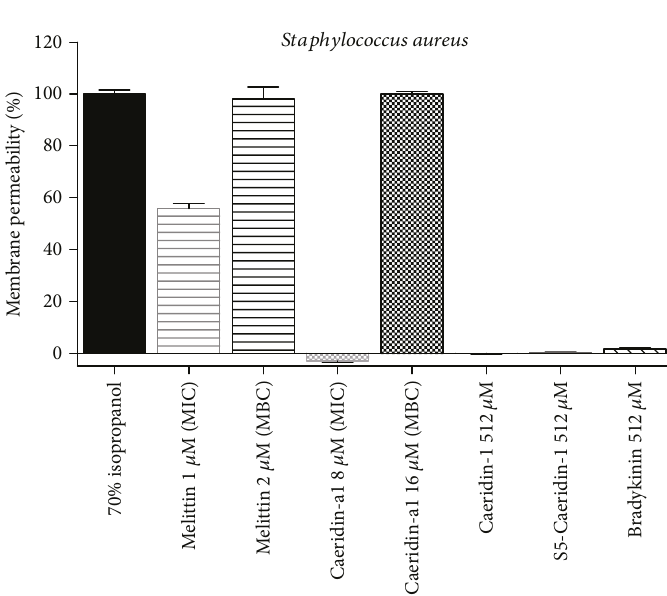
Figure 8: Membrane permeabilisation of S. aureus treated with melittin ( MIC = 1 μ M and MBC = 2 μ M ), Caeridin-a1 ( MIC = 8 μ M and MBC = 16 μ M ), Caeridin-1 (512 μ M), S5-Caeridin-1 (512 μ M), bradykinin (512 μ M), and 70% isopropanol for 2 h. The degree of membrane permeability was calculated in comparison with the maximum membrane permeabilisation control (70% isopropanol-treated). The error bars represent SEM of three independent experiments and each experiment with fi ve